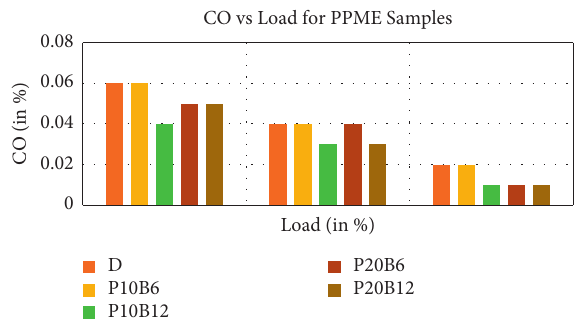
Figure 9: CO versus load for PPME Samples.